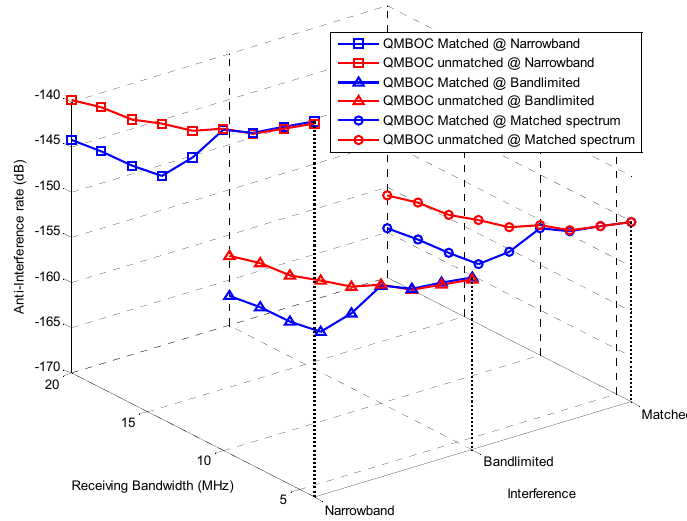
Figure 8. Anti-interference rate of QMBOC(6,1,1/11) with respect of receiving bandwidth, under the matched receiving and BOC 11 -like unmatched receiving. Three types of interferences are considered, including narrowband interference, bandlimited Gaussian interference and matched spectrum interference, of which the parameters setting of this figure is provided in Table 2.